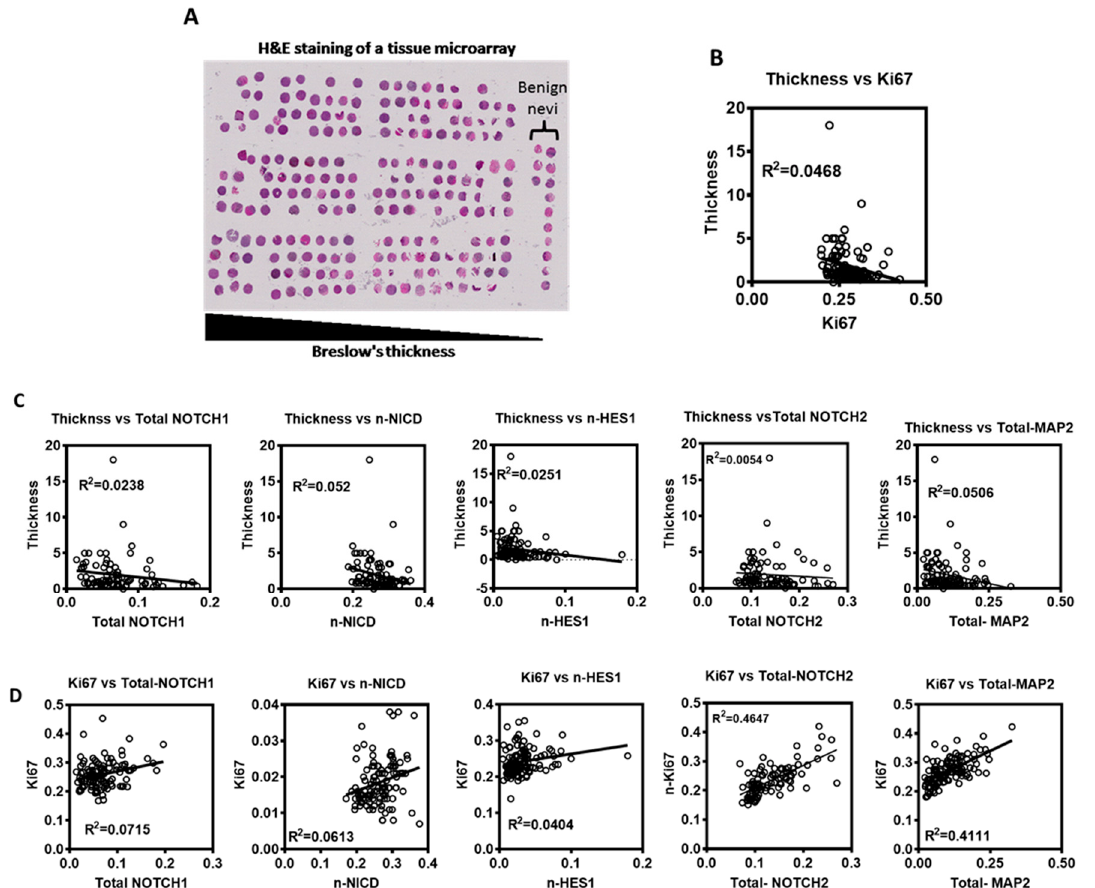
Figure 3. Notch signaling expression in human primary melanoma TMA. ( A ) Representative hema- toxylin and eosin staining (H&E) of the used TMA slides. ( B – D ) A linear regression analysis was used to assess the relationship between different markers and parameters in human primary melanoma tumors: ( B ) Tumor thickness vs. Ki67. ( C ). Tumor thickness vs. (total NOTCH1, nuclear NICD, nuclear HES1, total NOTCH2, or total MAP2). ( D ). Ki67 vs. (total NOTCH1, nuclear NICD, nuclear HES1, total NOTCH2, or total MAP2).